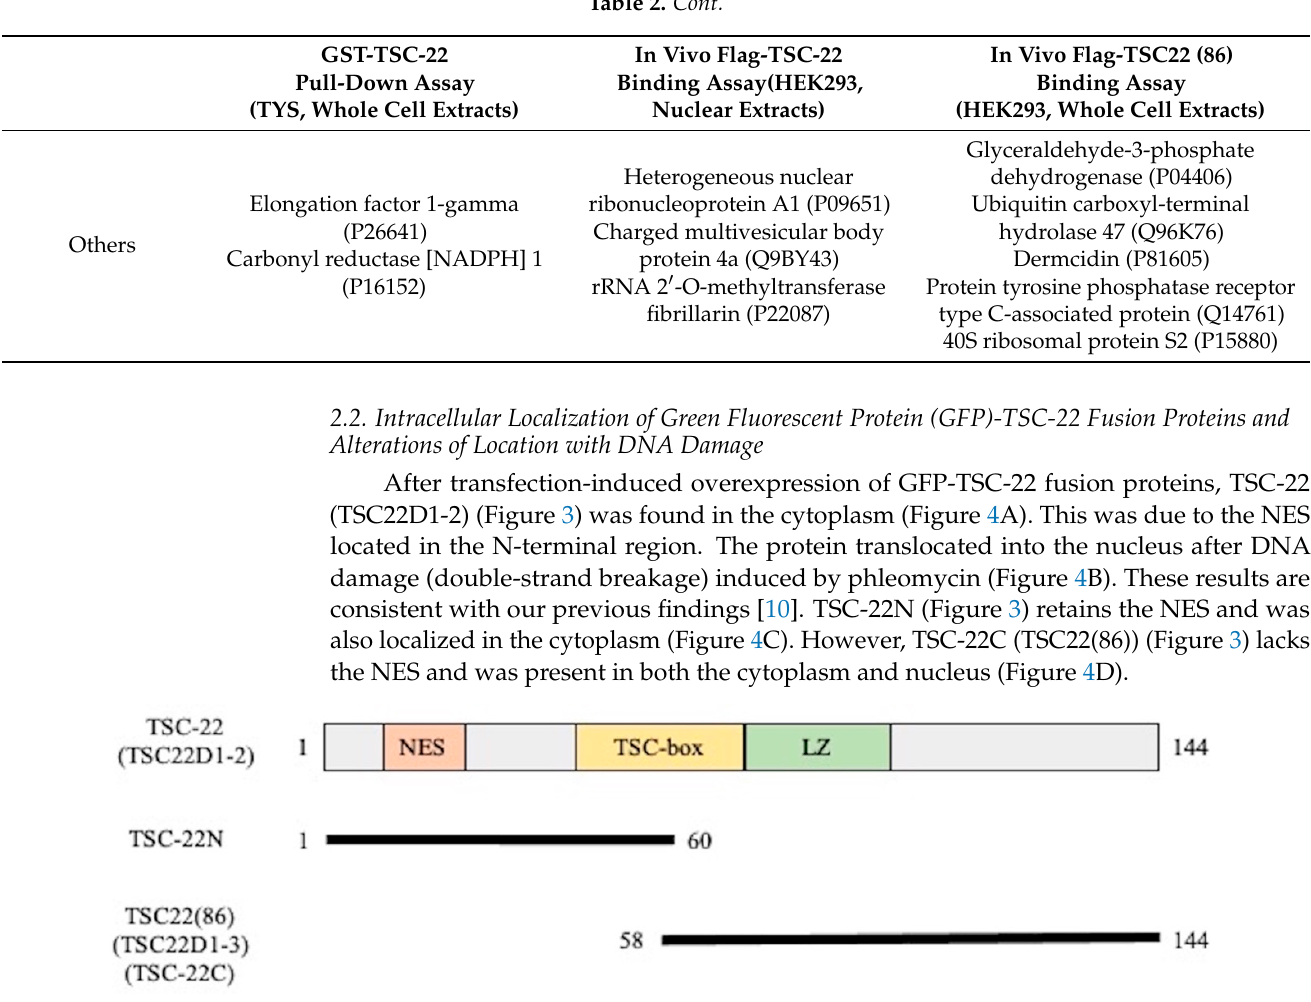
Figure 3. Structure of TSC-22 (TSC22D1-2) and truncation mutants used in this study. NES: nuclear export signal, LZ: leucine zipper. TSC-22N is not a naturally occurring protein.